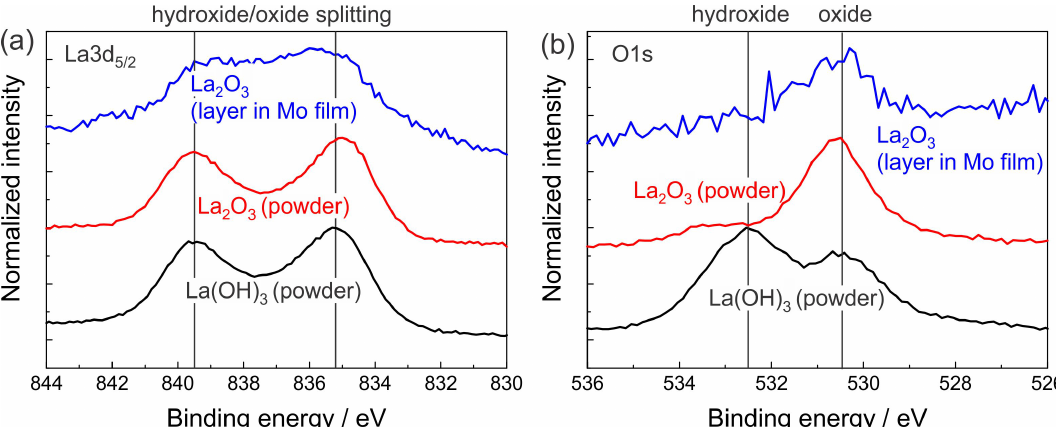
Figure 2. Results of the X-ray photoelectron spectroscopy (XPS) measurements of the ( a ) La3d 5/2 and ( b ) O1s peak for a La(OH) 3 powder reference, a La 2 O 3 powder reference and the 2 nm La-X layer deposited between two 10 nm thick Mo layers. The results indicate that the La-X layer is composed of La 2 O 3